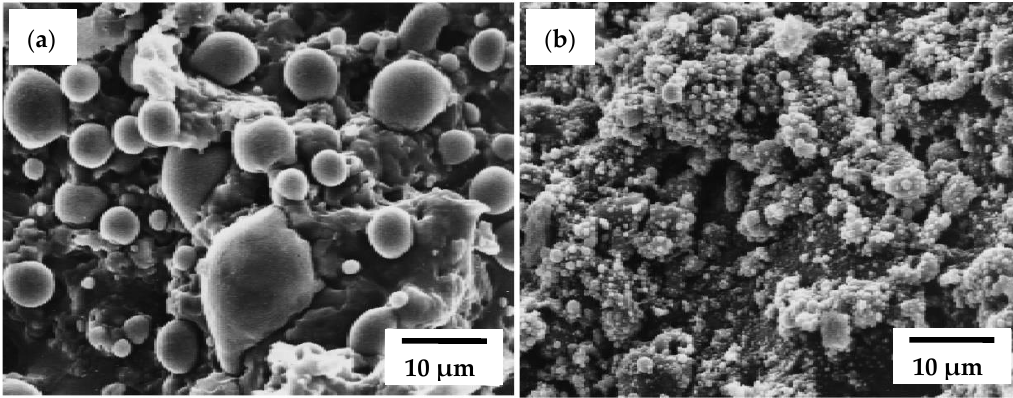
Figure 8. SEM examinations of fractures of cermets derived by combustion reactions at ( a ) T ad = 2950 K and ( b ) T ad = 1730 K. Reprinted with permission from Anselmi-Tamburini et al. (1998), Copyright 1998 Journal of the American Ceramic Society [67].